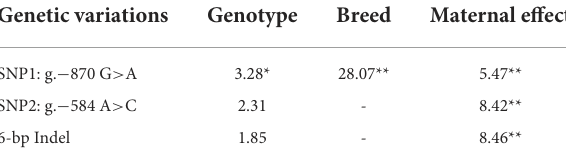
TABLE 4 Effects of genotype, breed and maternal effect of functional genetic variations in STAT3 gene on diarrhea score in Min pig and Landrace populations.